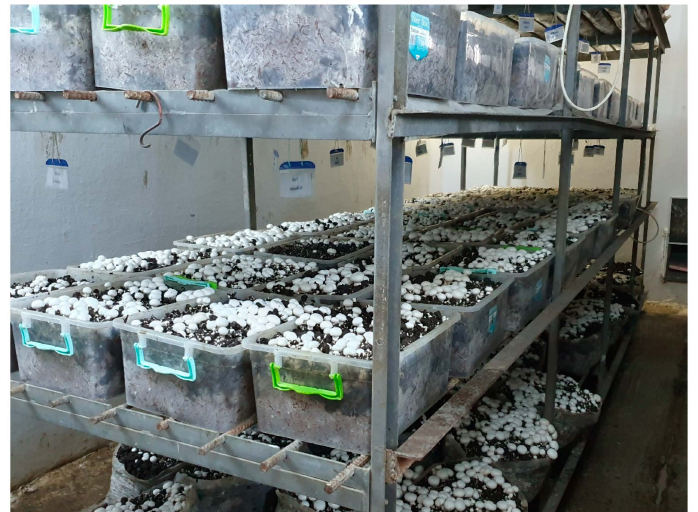
Figure 2. Experimental production